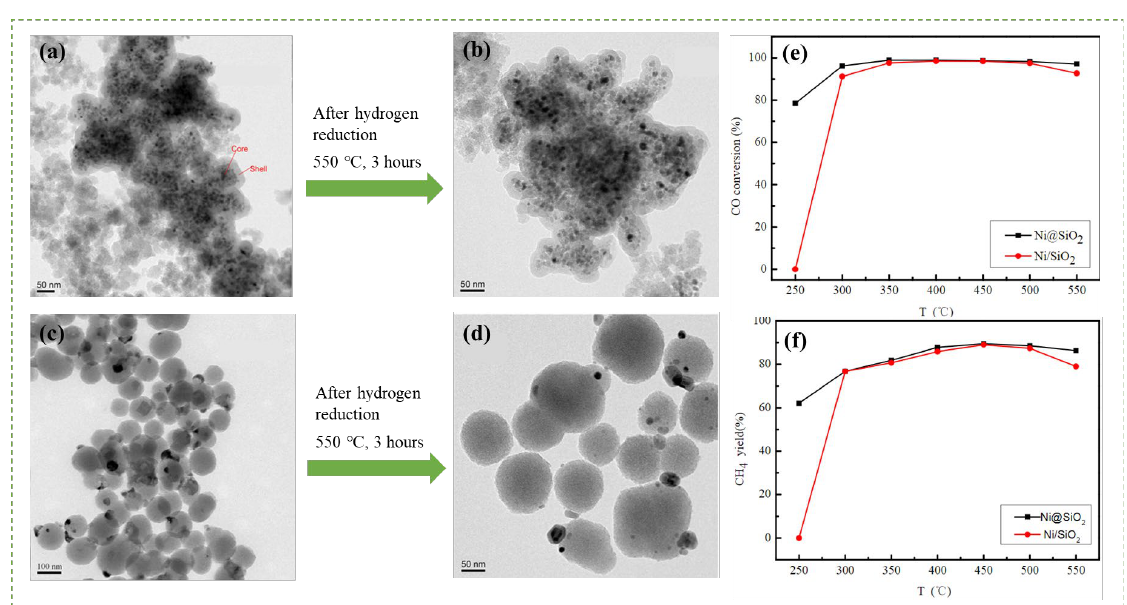
Figure 8. ( a ) Compilation of Ni/Mg@MCM-41 CSN synthesis by the in situ hydrothermal method and resultant SEM morphology of the core-shell structure formed, and the catalytic activities of Ni/MCM-41, Ni/0.05Mg@MCM-41, and Ni/0.1Mg@MCM-41, for comparison purposes between traditional and conventional CSN synthesis methods in terms of ( b ) stability of the catalysts in CO 2 conversion at 320 h rather than 120 h; ( c ) catalytic conversion of CO 2 ; and ( d ) selectivity of CH 4 . Retrieved with permission from Wang et al. [85] CO 2 methanation over Ni/Mg@MCM-41 prepared by in situ synthesis method; copyright from Elsevier, 2020.